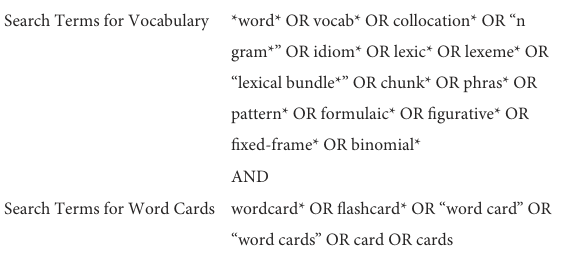
TABLE 4 The key terms used in the database